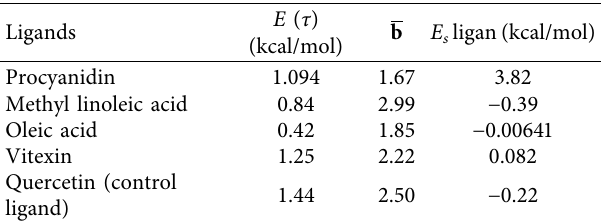
Table 6: Results of the calculation of the energy strain of each